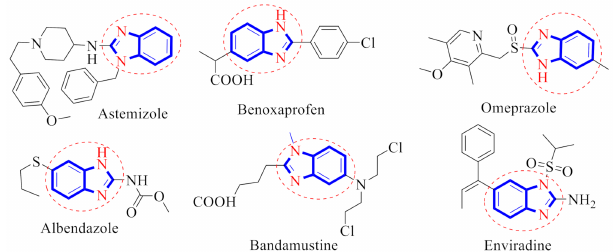
Figure 1. Drugs containing abenzimidazole skeleton.